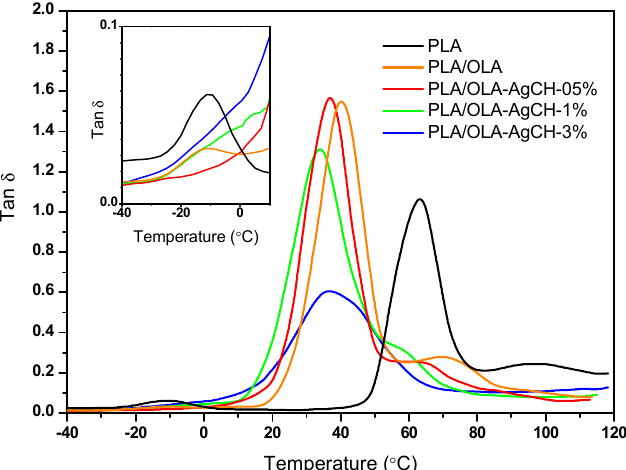
Figure 2. Temperature dependence of PLA, PLA / OLA and PLA / OLA-AgCH nanocomposite delta tangents (tan δ ) at a frequency of 1 Hz .